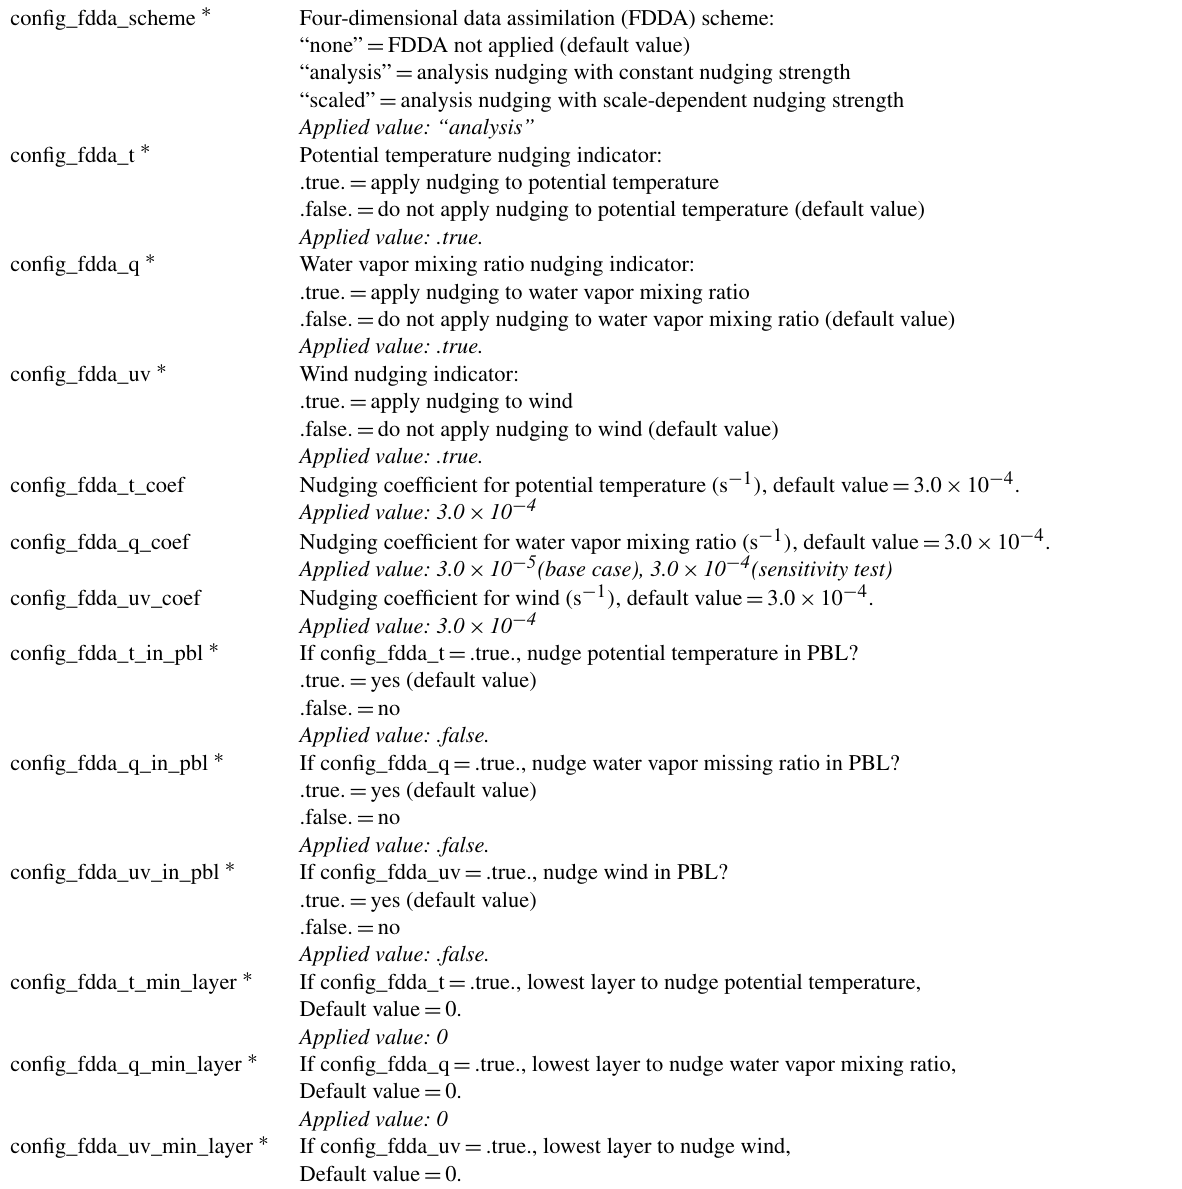
Table 3. New MPAS-A physics namelist variables added for the FDDA implementation and the values used for testing. config_fdda_scheme ∗ Four-dimensional data assimilation (FDDA)